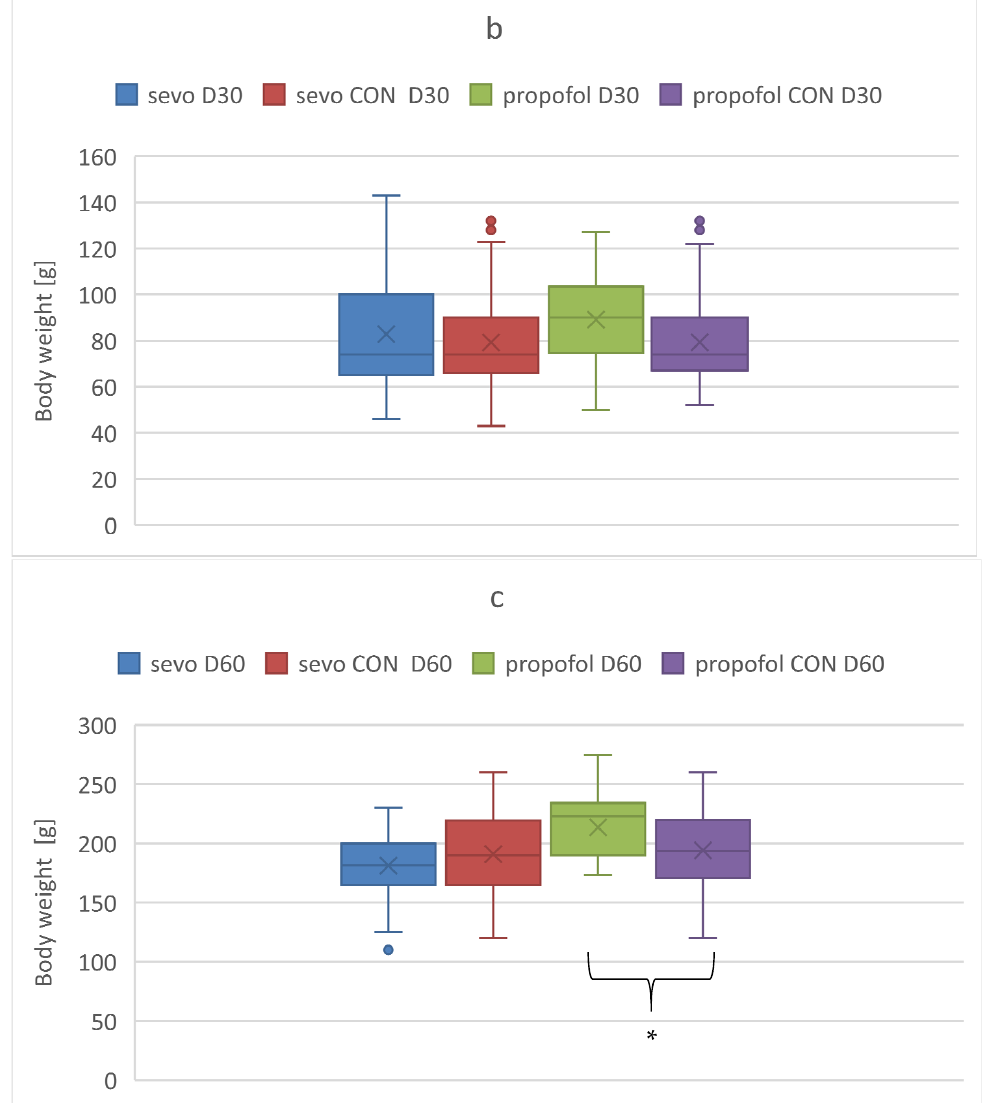
Figure 2. Rats’ body weight at D6, D30, D 60. ( a ) presents mean body weight [g] in the studied groups at D6. ( b ) presents mean body weight [g] in the studied groups at D30. ( c ) presents mean body weight [g] in the studied groups at D60: sevo D6; sevo D30; sevo D60—mean body weight in the group randomized to sevoflurane at D6, D30, D60; propofol D6; propofol D30; propofol D60—mean body weight in the group randomized to propofol at D6, D30, D60; sevo CON D6; sevo CON D30; sevo CON D60- mean body weight in the group randomized to control for sevoflurane at D6, D30, D60; propofol CON D6; propofol CON D30; propofol CON D60—mean body weight in the groups randomized to control for propofol at D6, D30, D60. Crosses represent mean. Whiskers represent standard deviation. Dots represent outliers. Boxes represent inter-quartile range. Horizontal lines represent medians. Data were checked for normality with the Shapiro-Wilk test. One-way ANOVA was used for multiple comparison with post hoc Bonferroni test. * p < 0.05 was assumed as statistically